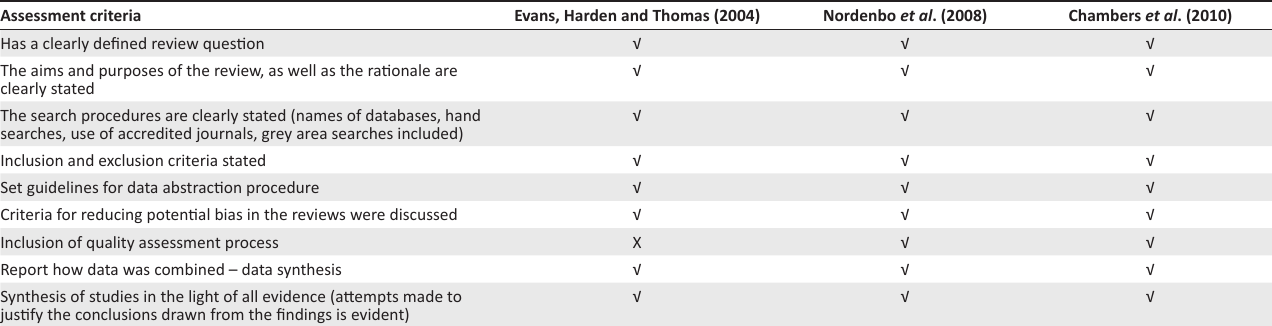
TABLE 2: Quality